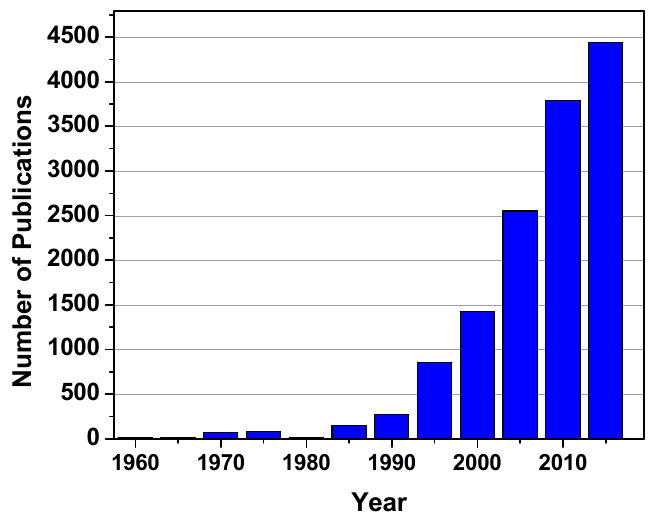
Figure 2. The number of publications with block copolymer as topic against year. The data were obtained from Web of Science (2017 Clarivate Analytics).